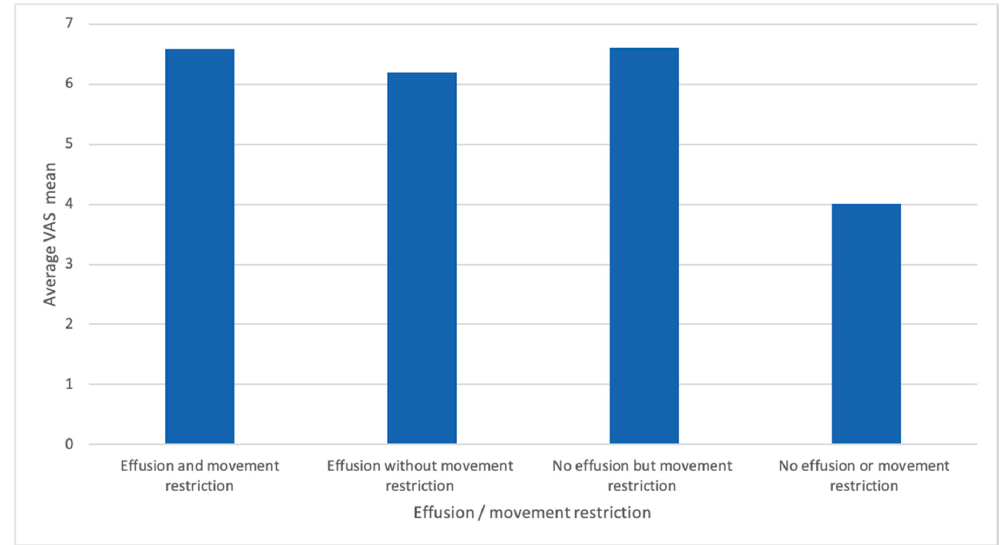
Figure 5. Correlation between VASp and effusion/movement restriction . VASp = visual analogue scale for pain.